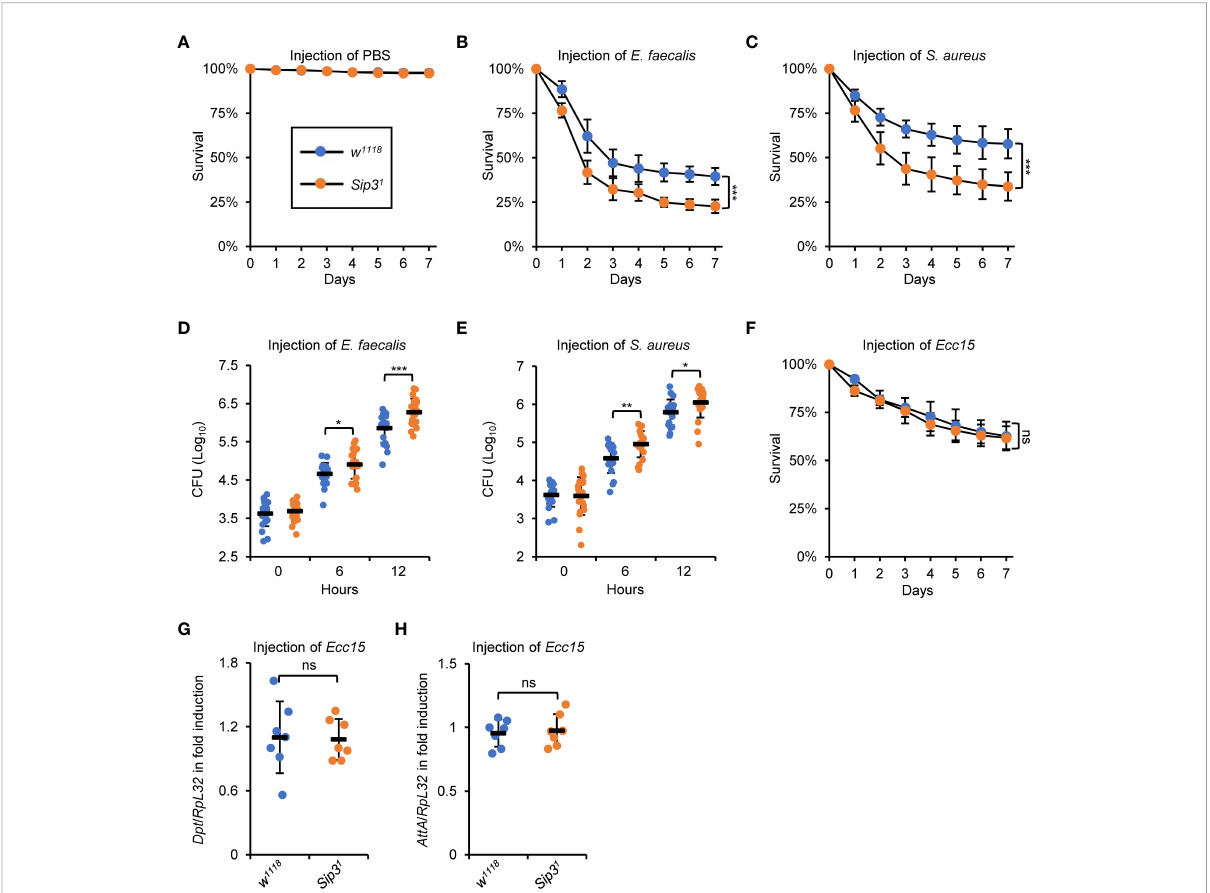
FIGURE 2 Sip3 contributes to the host resistance against injected bacteria. (A – C) Wild-type and Sip3 mutant fl ies were infected with sterile PBS (A) , E. faecalis (B) , or S. aureus (C) . Flies were then counted for mortality every day. The numbers of fl ies analyzed in A, B and C were as follows. In (A) , WT : 104, 105, 105; Sip3 : 105, 102, 107. In (B) , WT : 107, 106, 103; Sip3 : 104, 107, 105. In (C) , WT : 105, 107, 103; Sip3 : 104, 102, 106. (D, E) Wild- type and Sip3 mutant fl ies were infected with E. faecalis (D) , or S. aureus (E) . At indicated time points (0, 6, and 12 h), fl ies were subjected to bacterial burden assays. Each dot represents one independent replicate (10 fl ies for each replicate). (F – H) Wild-type and Sip3 mutant fl ies were infected with Ecc15 , followed by survival rate assays (F) or RT-qPCR assays (G, H) . In (F) , the numbers of fl ies were as follows. WT : 104, 107, 105; Sip3 : 105, 102, 107. In (G) and (H) , each dot represents one independent replicate (10 fl ies for each replicate). All the data were shown as mean ± standard errors. * p < 0.05; ** p < 0.01; *** p < 0.001; ns, not signi fi